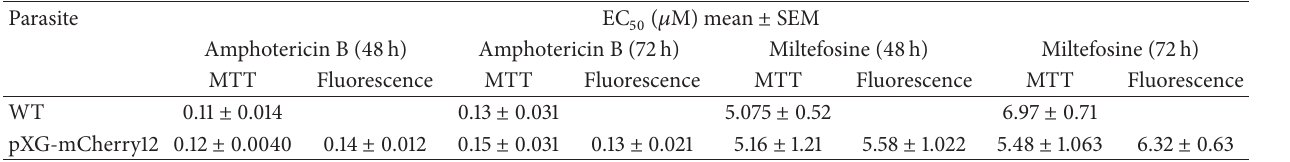
Table 2: Drug activity profile of L. major cell lines. Promastigotes were grown, as described in Materials and Methods, for 48 and 72 hours at 26 ∘ C in the presence of increasing drug concentrations. The 50% effective concentrations (EC 50 ) were measured using an MTT-based assay and a FLUOstar Optima fluorimeter for WT and pXG-mCherry12 parasites. Results are expressed as mean ( ± standard error [SEM]) from three independent